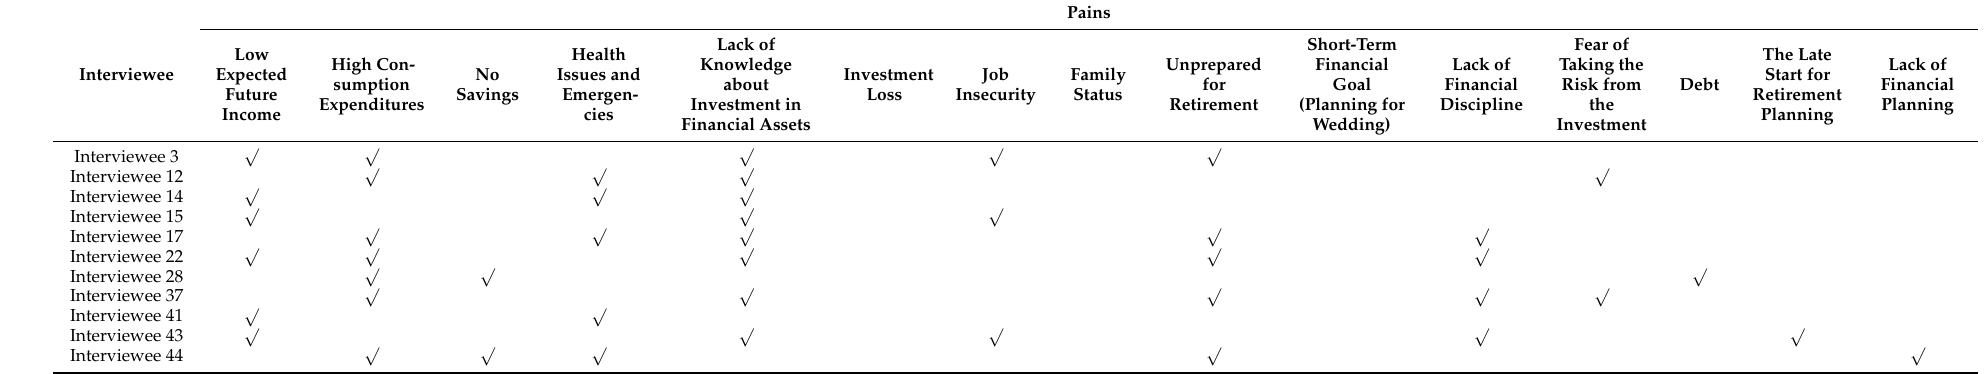
Table 5. Most common pains from interviewees of segment